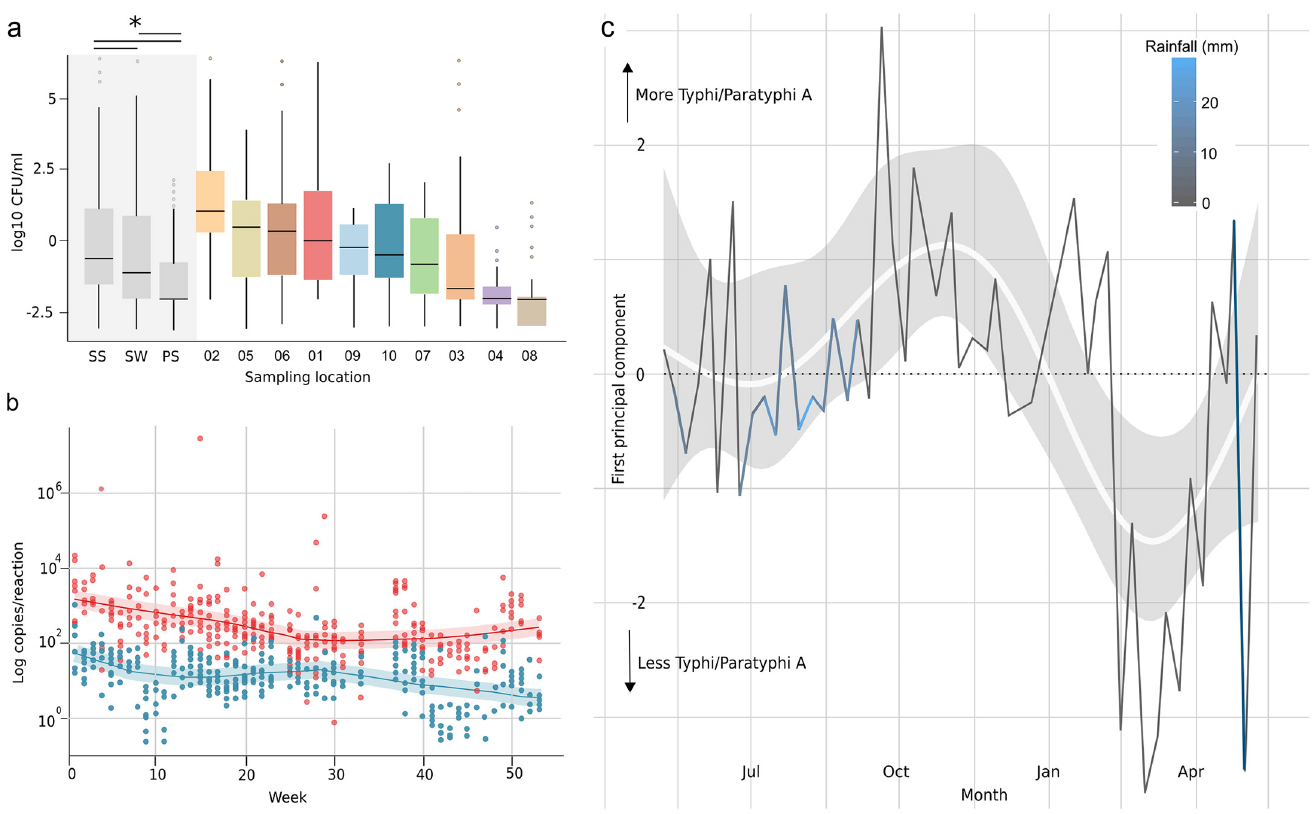
Fig 2. The quantification of coliforms and DNA from Salmonella serovars Typhi and Paratyphi A in water samples from ten locations in Kathmandu, Nepal. a) Boxplots of the MPN counts (log10 CFU/ml) aggregated by water sources type (SS, stone spout; SW, sunken well; PS, piped supply) and within each individual location (numbered on x-axis). Boxes and horizontal lines represent the interquartile ranges and medians, respectively and whiskers represent 90% of data range. The median MPN measurements in water from stone spouts; sunken wells and piped supplies were significantly different; as determined by Kruskal Wallis test ( p < 0.001; shown by the asterisk). b) Scatterplots showing the number of copies of S . Typhi (red circles) and S . Paratyphi A (blue circles) gene targets calculated to be in each water sample (by realtime PCR amplification and quantification using a standard curve) against the week of sampling. The red and blue shaded lines show the best fit through time of gene copy quantification trends for S . Typhi and S . Paratyphi A, respectively. c) Principal components analysis of the weekly presence/absence profiles of S . Typhi and S . Paratyphi A gene targets in water samples, shaded by weekly rainfall (see key). Time is represented on the x-axis. The first principal component, representing fluctuations in S . Typhi and S . Paratyphi A DNA relative abundance, is plotted on the y-axis.